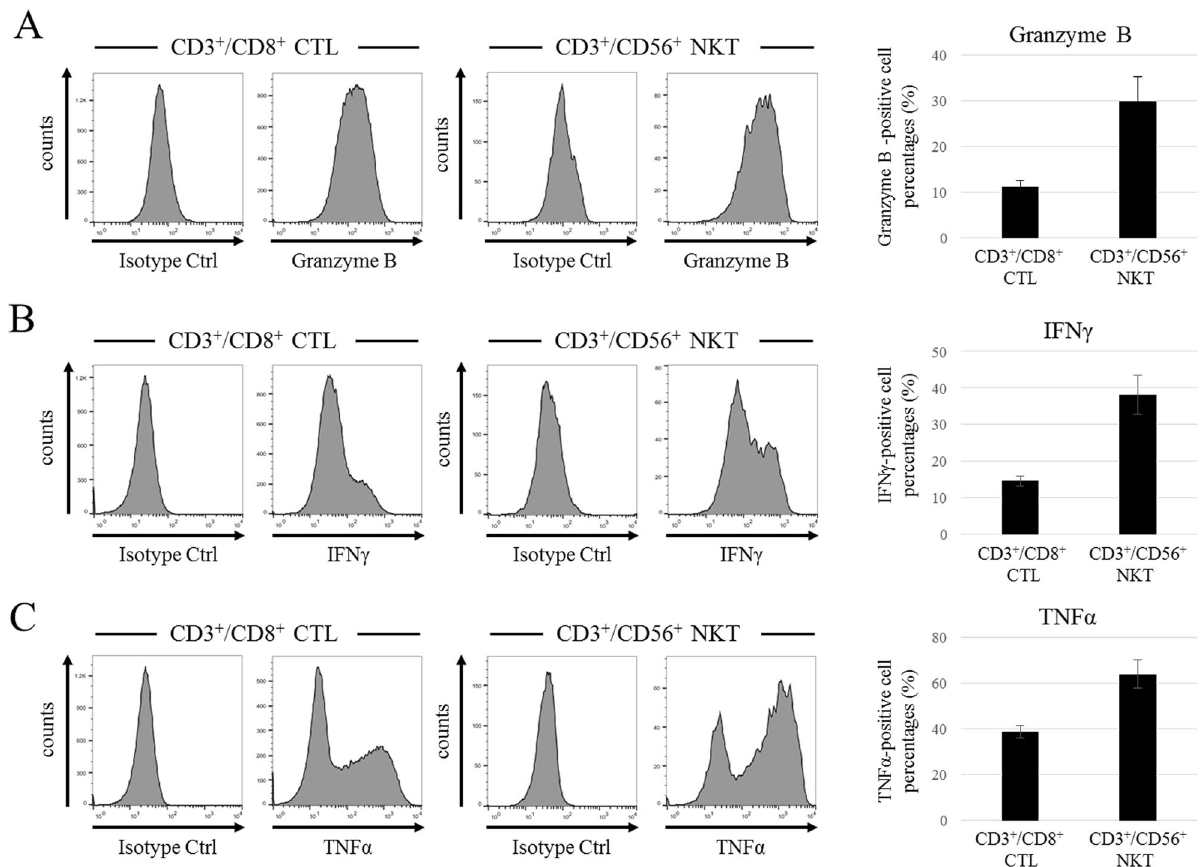
Figure 4. Production of granzyme B and cytotoxic cytokines by CD3 + /CD8 + CTL and CD3 + /CD56 + NKT cell populations in the mixed immune cells. ( A ) FCM histogram data of granzyme B production by CD3 + /CD8 + CTLs and CD3 + /CD56 + NKT cells, and the percentages of granzyme B-positive cells in each population ( n = 3). ( B ) FCM histogram data of IFN-γ production by CD3 + /CD8 + CTLs and CD3 + /CD56 + NKT cells, and the percentages of IFN-γ-positive cells in each population ( n = 3). ( C ) FCM histogram data of TNF-α production by CD3 + /CD8 + CTLs and CD3 + /CD56 + NKT cells, and the percentages of TNF-α-positive cells in each population ( n = 3). The data are shown as means ±